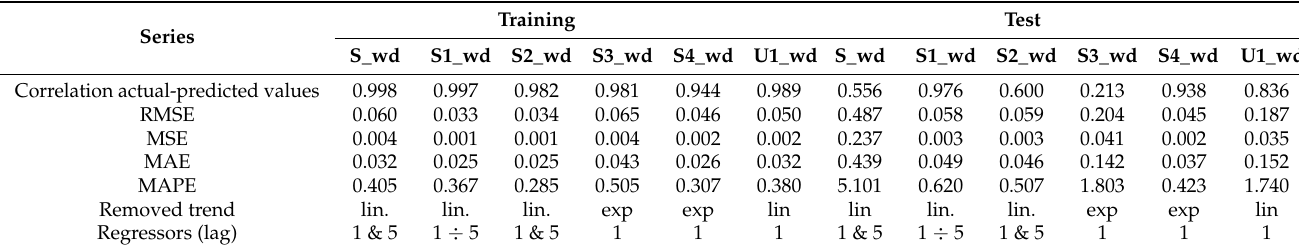
Table 15. Performances of the best models built for the S_w and its subseries, after the trend removal. The detrended series are denoted by S_wd, S1_wd, S2_wd, S3_wd, S4_wd, and U1_wd.